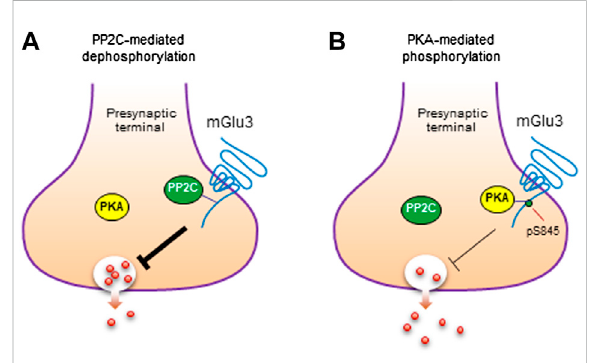
FIGURE 3 Phosphorylation and dephosphorylation of mGlu3 receptors. (A) Dephosphorylation of mGlu3 receptors by PP2C. PP2C dephosphorylates mGlu3 receptors at a speci fi c serine residue (S845) in the C-terminus (CT) region of the receptor. (B) Phosphorylation of mGlu3 receptors by PKA. PKA phosphorylates mGlu3 receptors at S845 and increases the level of S845- phosphorylated (pS845) mGlu3 receptors. Such phosphorylation inhibits the PP2C association with mGlu3 CT and may exert an inhibitory control over the presynaptic function of mGlu3